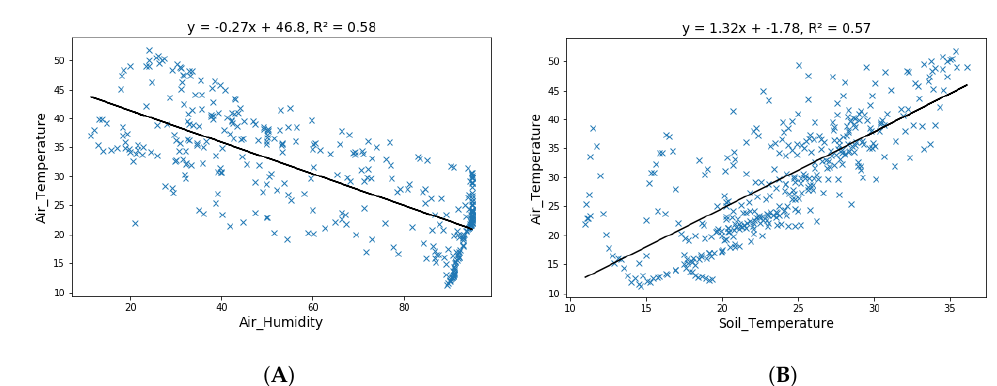
Figure 6. ( A ) Correlation b/wair temperature and air humidity. ( B ) Correlation b/w air temperature and soil temperature.